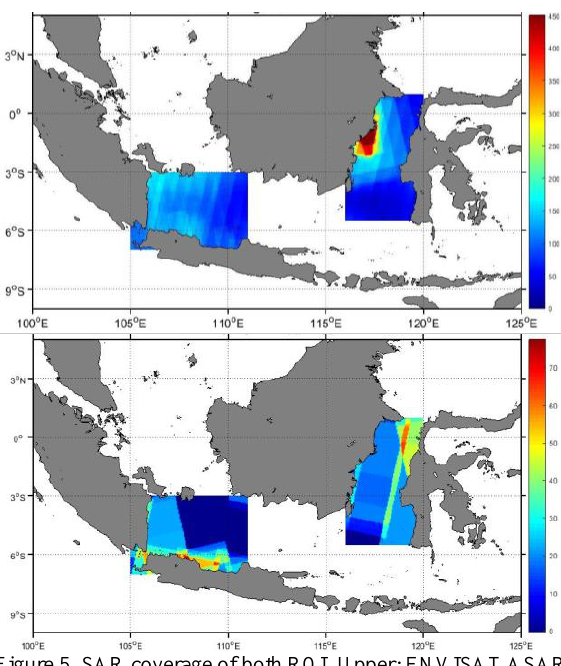
Figure 5. SAR coverage of both ROI. Upper: ENVISAT ASAR; lower: Sentinel-1A/B